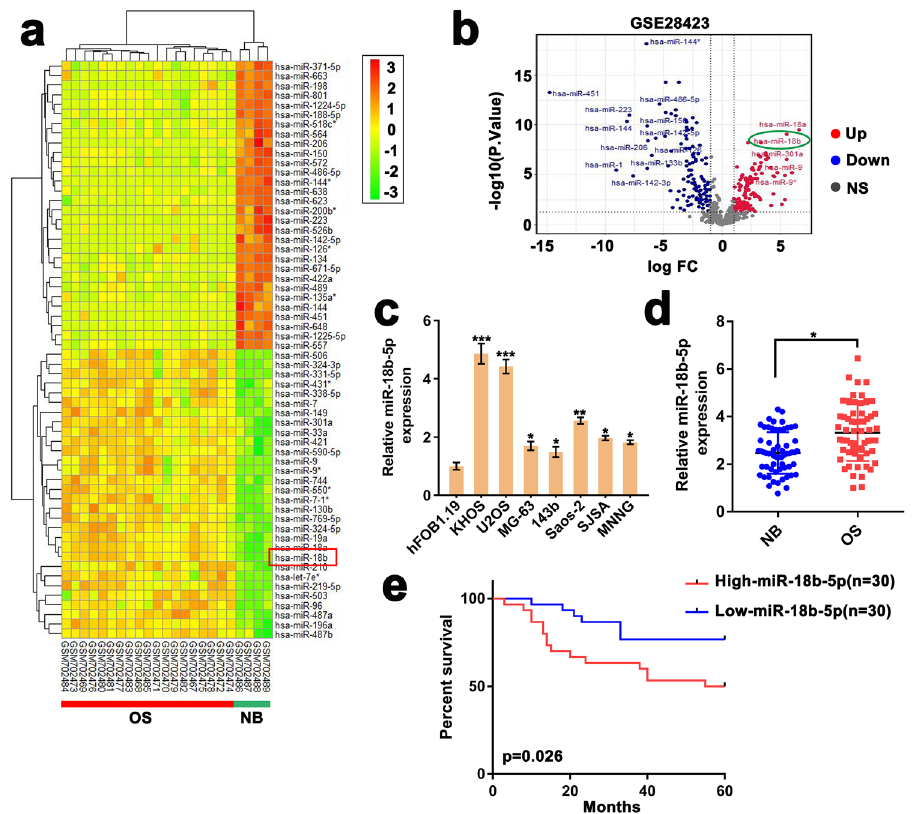
Figure 1. miR-18b-5p is upregulated in OS and associated with poor clinical outcome. ( a ) Heatmap of microarray data obtained from GEO datasets (GSE28423) showed 60 most upregulated and downregulated miRNAs in OS cells and normal osteocytes. The image was created by RStudio (pheatmap). ( b ) The volcano plot showed differential expressed miRNAs (log2 fold change > 2, p < 0.001). The image was generated by RStudio (ggplot2). ( c ) RT-qPCR assay showed the miR-18b-5p expression in 7 OS cell lines compared with normal bone cells (hFOB1.19). ( d ) RT-qPCR assay showed the miR-18b-5p expression in 60 OS tissues and paired adjacent normal tissues (NB). ( e ) Kaplan–Meier curves analysis displayed the percentage survival of 60 OS patients in high and low miR-18b-5p groups. The 50th percentile of miR-18b-5p expression was a cutoff point divided into “high” and